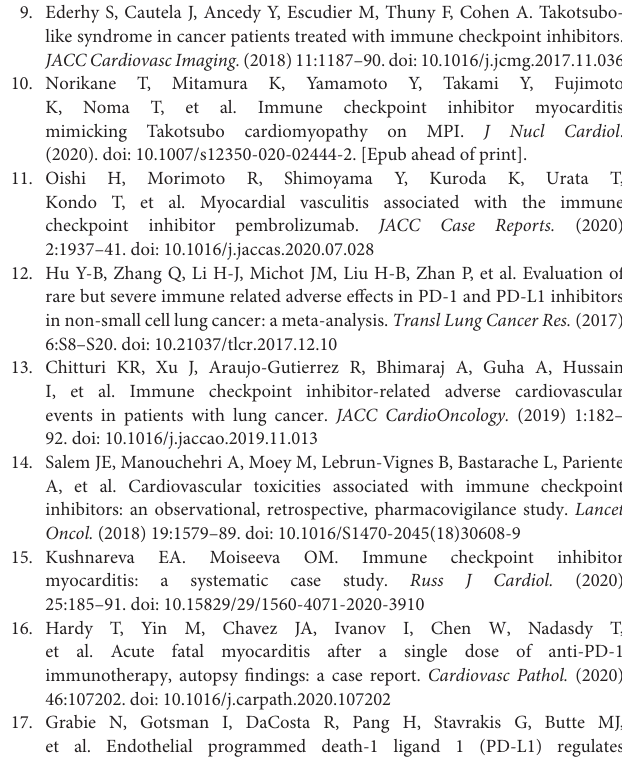
Supplementary Figure 1 | Correlations between PD-L1 expression (CMPS, ICDPS) and white blood cells (WBC) count in peripheral blood. (A) Significant strong positive correlation between CMPS and WBC; (B) significant strong positive correlation between CMPS and neutrophils; (C) significant strong positive correlation between ICDPS and WBC; (D) significant strong positive correlation between ICDPS and